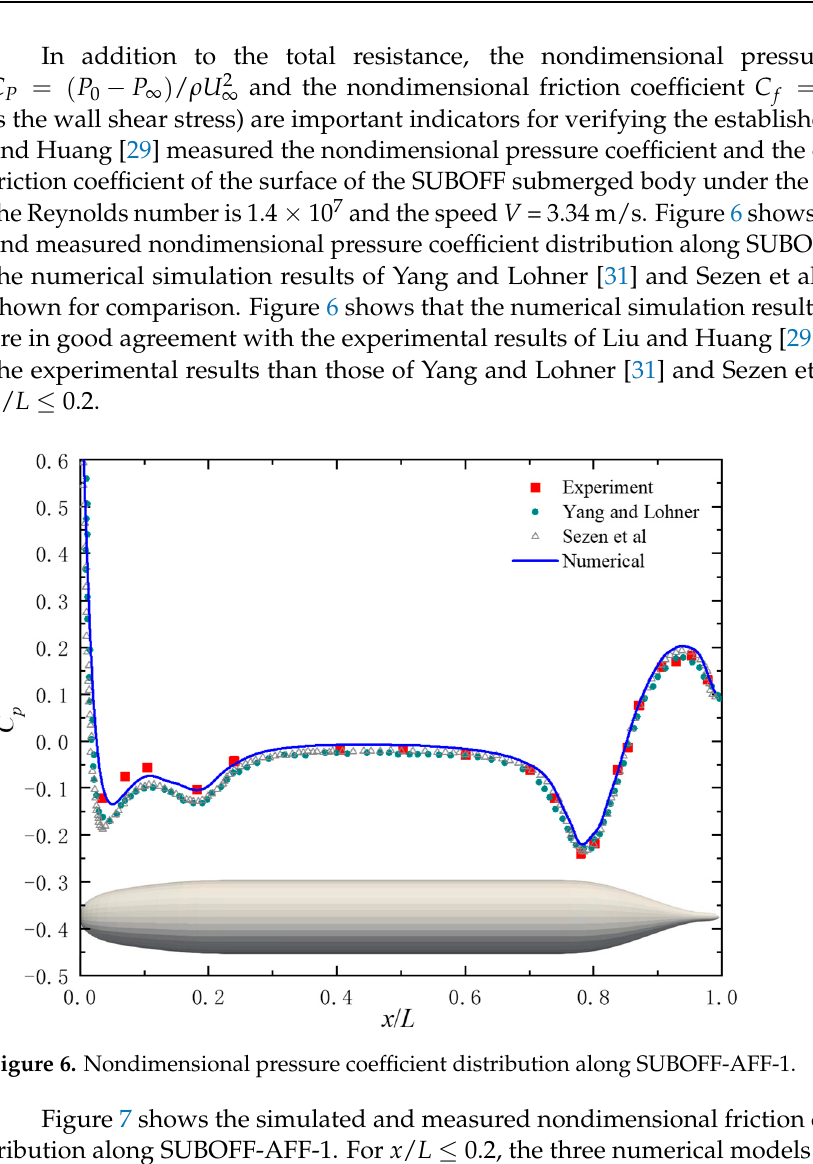
Table 4. Relative error of numerical and experimental resistance values for SUBOFF-AFF-8.